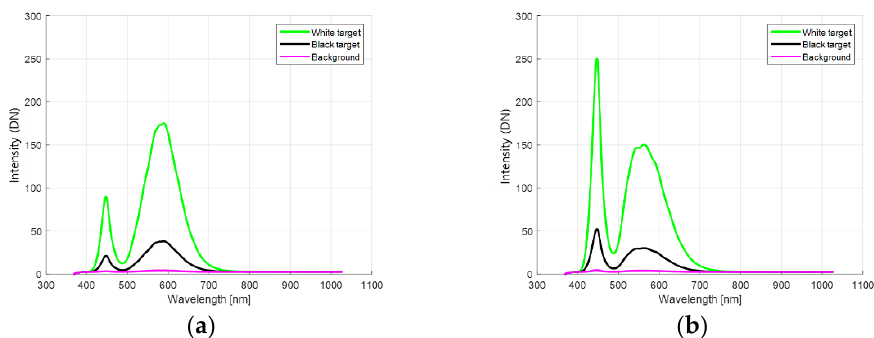
Figure 2. Headlamp light output characteristics identified indirectly by profile raw data from the spectral camera for headlamp light reflected by pedestrian targets in clear condition; ( a ) 3000 K lighting; ( b ) 6000 K lighting.